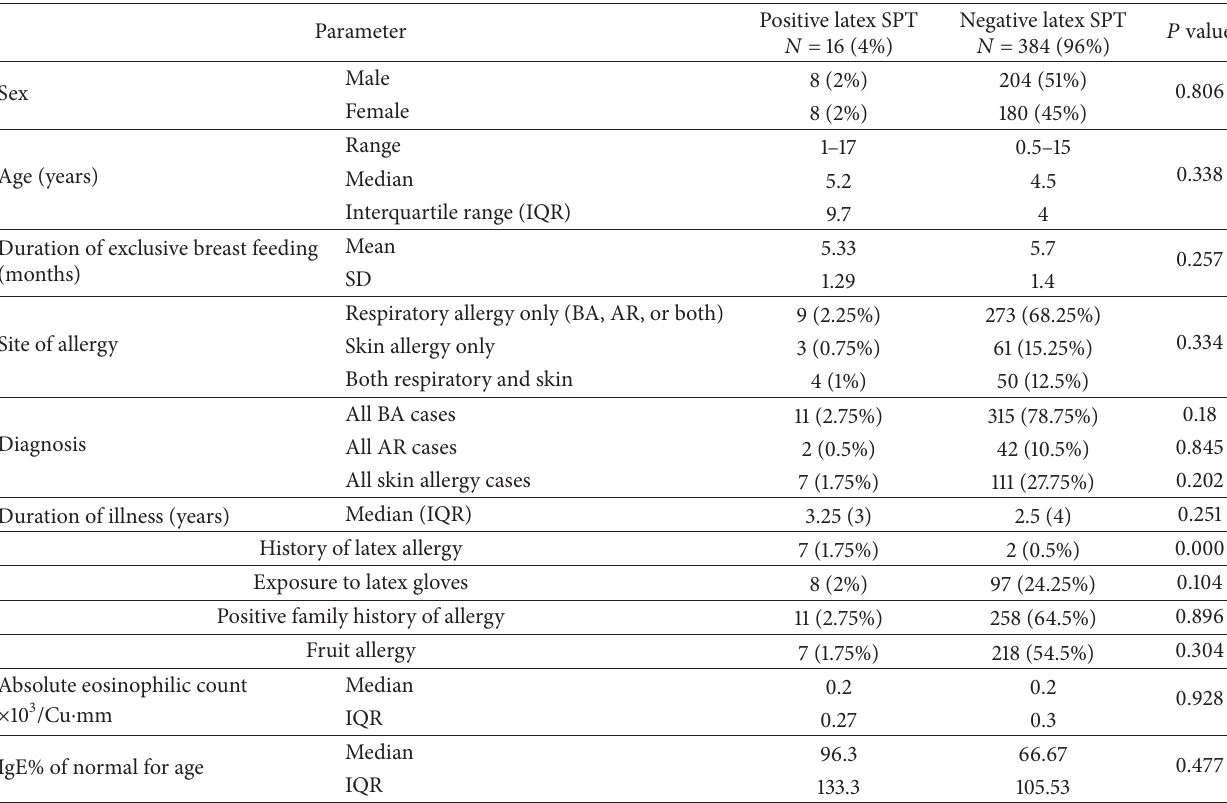
Table 1: Demographic and clinical data of patients.